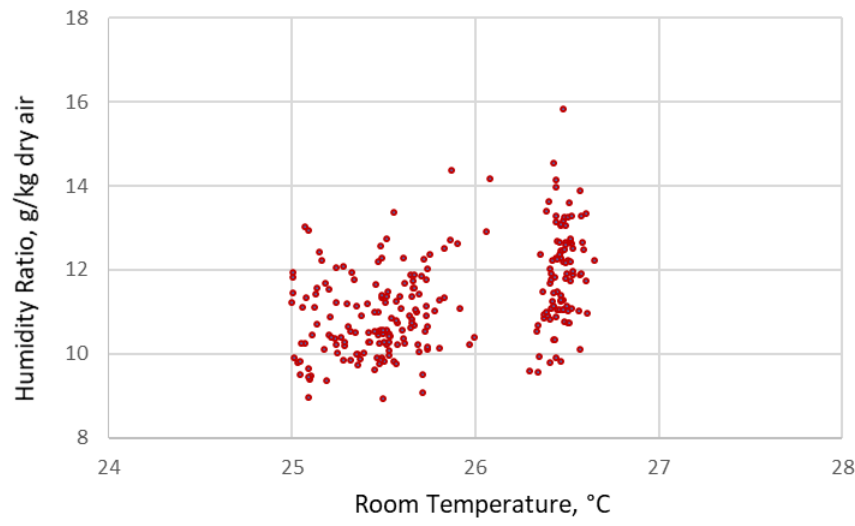
Figure 13. Temperature vs humidity ratio-bedrooms.